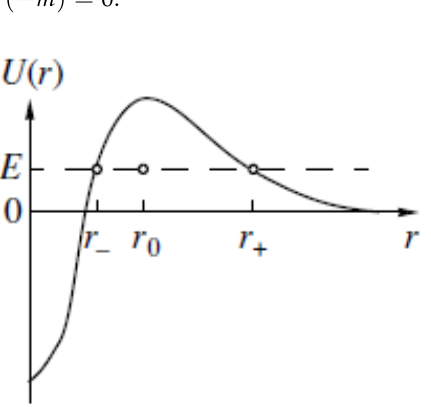
Figure 1. Typical dependence of effective Schrödinger potential U on r for a charged particle in an electric central-symmetric potential well, r ± are turning points, and r 0 corresponds to maximum of the effective potential U . The dashed line describes the quasistationary level with (cid:101) < − m . For Z < Z cr electrons of the lower continuum (with (cid:101) < − m ), fill all energy